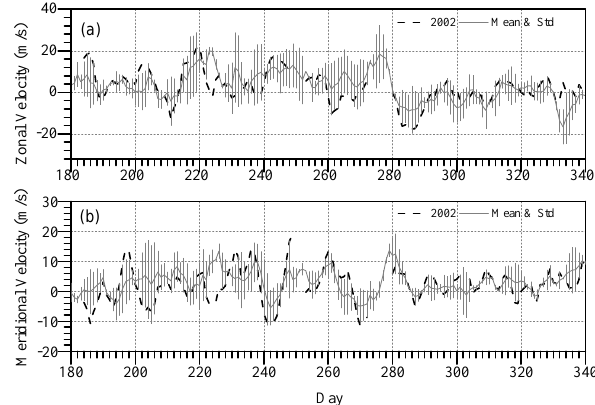
Fig. 3. Time evolution of daily averaged (a) zonal and (b) meridional velocities obtained from SANAE HF radar observations from 1 July to late November 2002. The figure is superimposed with the 2003–2006 mean profile with standard deviation.